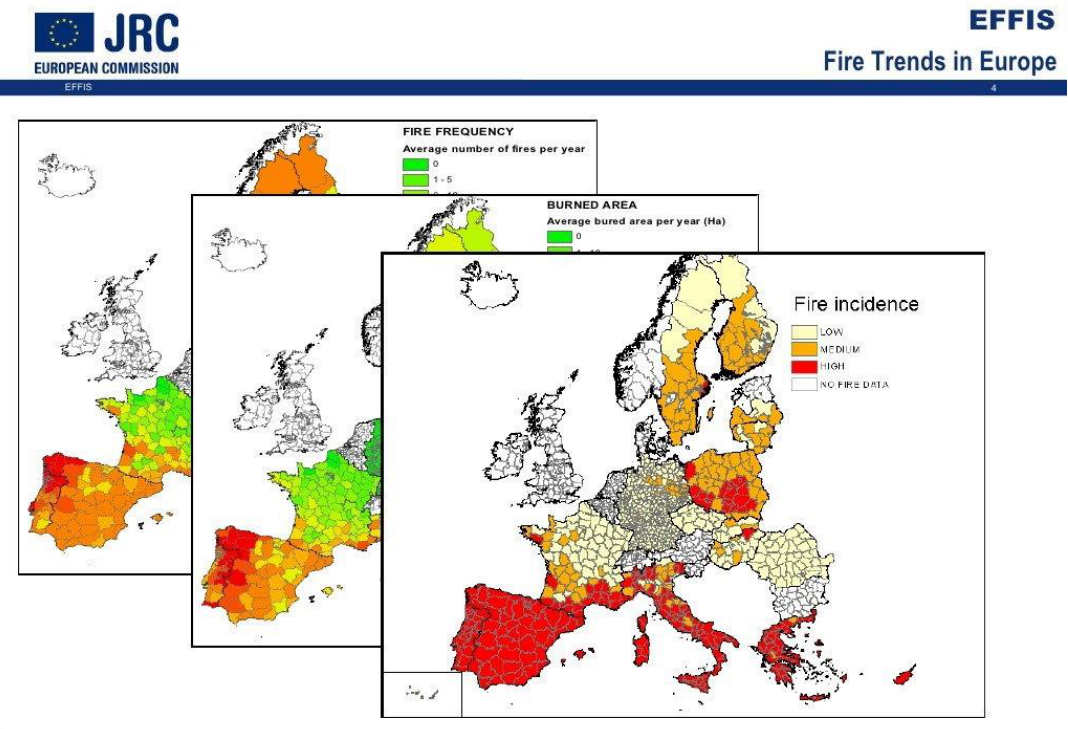
Figure 3: Increasing risk for Wildfires (Joint Research Centre